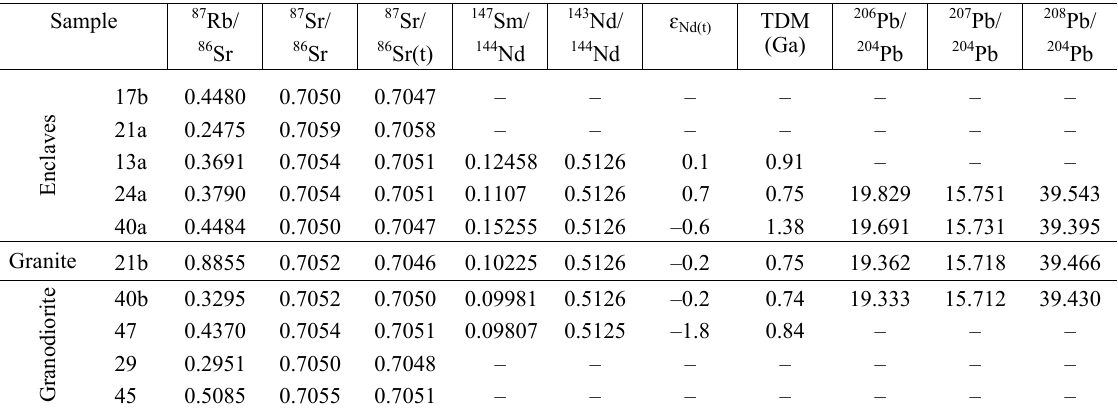
Table 2. Results of the whole-rock Sr, Nd and Pb isotope analyses of the enclave and hosts 87